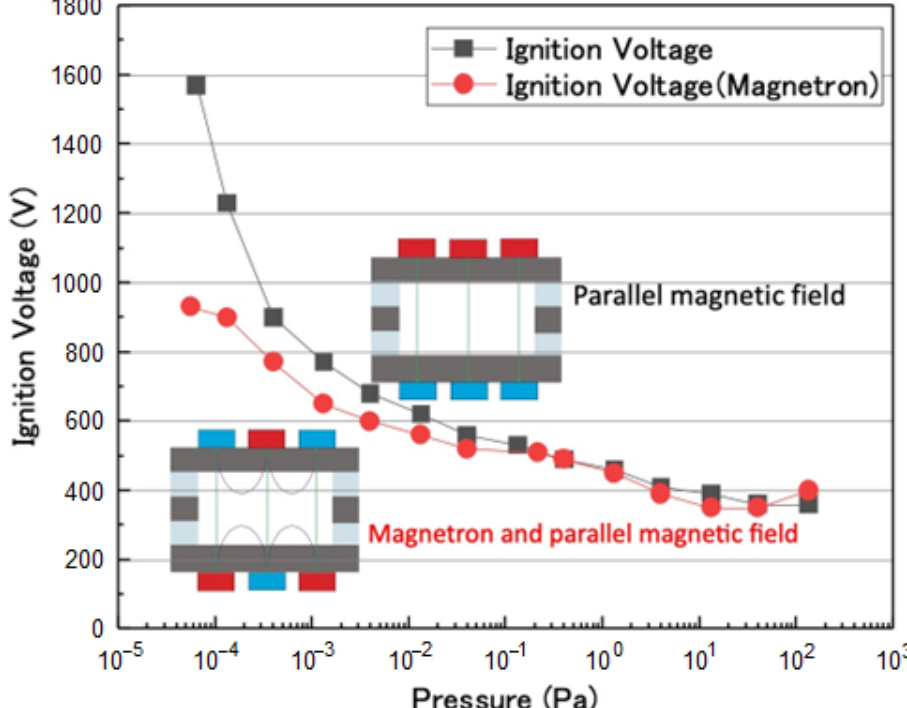
Figure 6. Ignition voltage depending on pressure for two types of magnetic circuits.